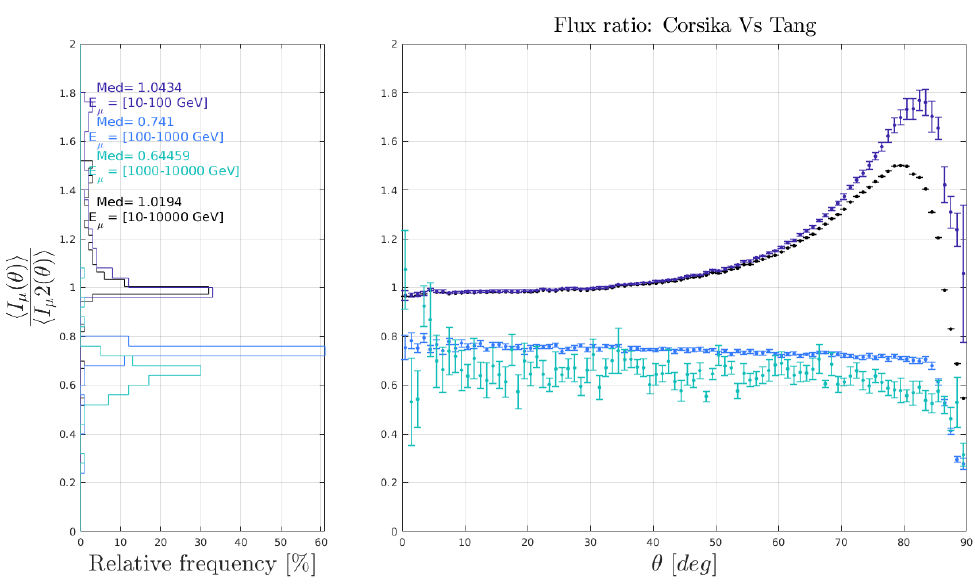
Figure 5. ( Left panel ) Histogram of flux ratio values computed over the zenith angle range (details are shown in the right figure) for several energy ranges from 10 to 10 4 GeV (in color) and for the whole energy range (in black). ( Right panel ) Flux ratio as a function of the zenith angle θ between (1) CORSIKA and (2) Tang et al. [19], for the same energy ranges as the left panel. The latter is the reference flux (ratio denominator). Med corresponds to the median value in each energy range.